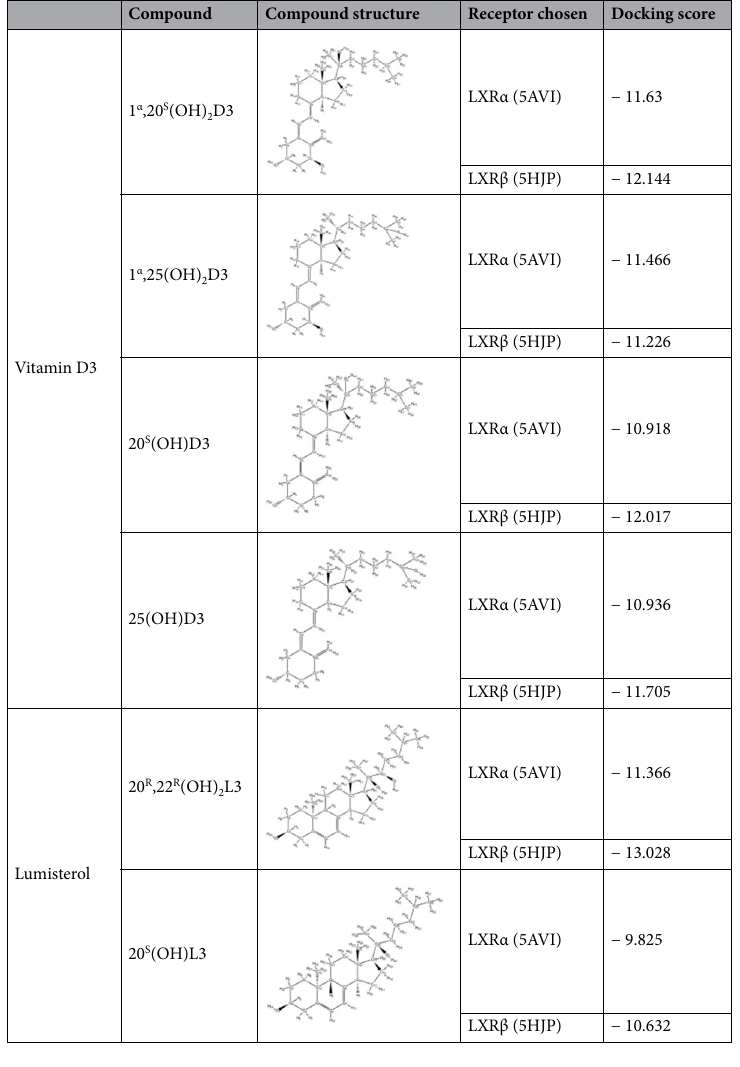
Table 2. The selected compounds and the identified crystal structures of LXRα (LBD) (PDBID 5AVI) and LXRβ (LBD) (PDBID 5HJP) for the MD studies and Glide XP docking scores for the ligands with